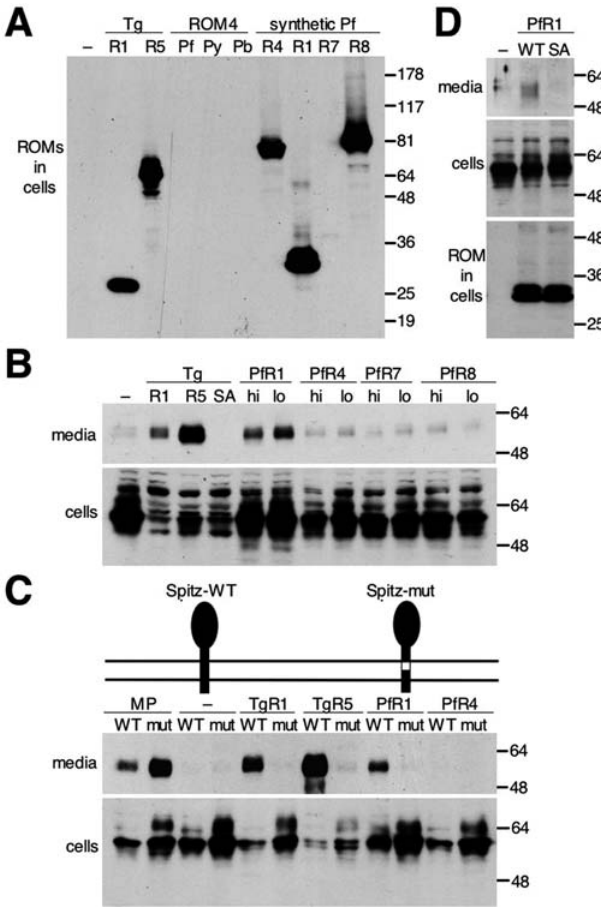
Figure 2. Expression Levels and Proteolytic Activity of Plasmodium Rhomboid Proteins (A) Expression levels of 3xHA-tagged rhomboid proteins in transiently transfected COS cells were detected by anti-HA Western analysis. The approximate positions of prestained molecular weight standards (in kDa) are indicated on the right. Tg denotes T. gondii , Pf is P. falciparum , Py is P. yoellii , and Pb is P. berghei . (B)Cleavageof Drosophila SpitzproteinintransientlytransfectedCOScells was analyzed by anti-GFP Western analysis of media. Labeling above each panel denotes which rhomboid enzyme was co-transfected with Spitz to assess cleavage. Cleaved Spitz is rapidly secreted into the cell culture media,whilecell lysatesindicatetransfection levels.Notethattransfection of high concentrations of PfROM DNA (hi) resulted in some cytotoxicity relative to lower amounts (lo), which is common for many rhomboid proteins (C) Cleavage of Spitz versus Spitz with the top seven amino acids of its transmembrane domain mutated to VALVIGV. Diagram denotes Spitz (in black), and mutant region (in white), with its cytoplasmic region being downward and the membrane bilayer denoted by two horizontal lines. Spitz shedding by endogenous cellular proteases was reduced by including a metalloprotease inhibitor in the cell culture media (in all lanes except those labeled MP). Note that both forms of Spitz were cleaved efficiently by cellular metalloproteases (MP), indicating that both forms were expressed well and trafficked to the cell surface, but the mutant Spitz could not be cleaved by rhomboid enzymes. (D) PfROM1 depends on its putative active site serine for activity against Spitz.Bothwild-typeandSAmutantPfROM1proteinswereexpressedwell in transfected COS cells, as revealed by anti-HA Western (lower panel). DOI: 10.1371/journal.ppat.0020113.g002 PLoS Pathogens |